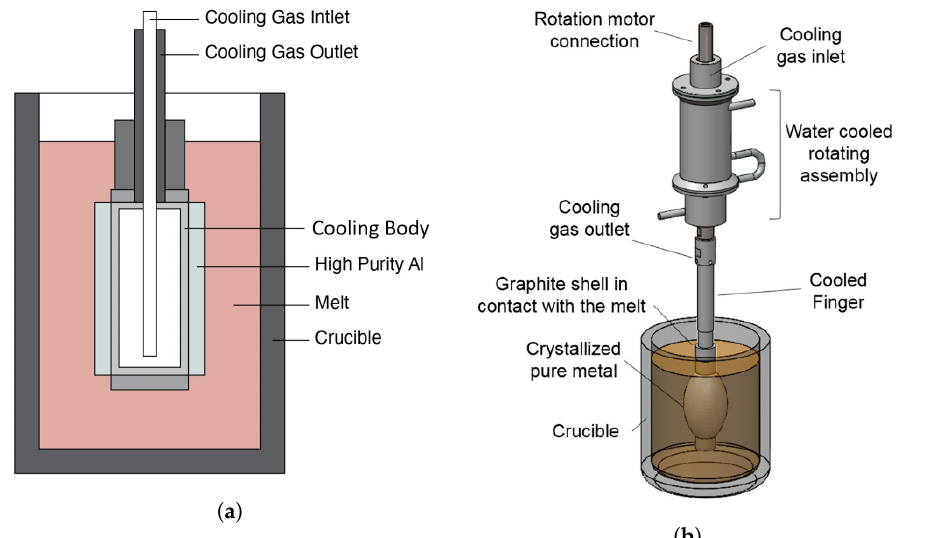
Figure 11. ( a ) Fractional crystallization sketch of the cooled finger process, as used by Japanese Showa Aluminum Corporation, adapted from [71] and ( b ) fractional crystallization sketch of the cooled finger process developed at the IME institute from RWTH Aachen University, adapted from [41].